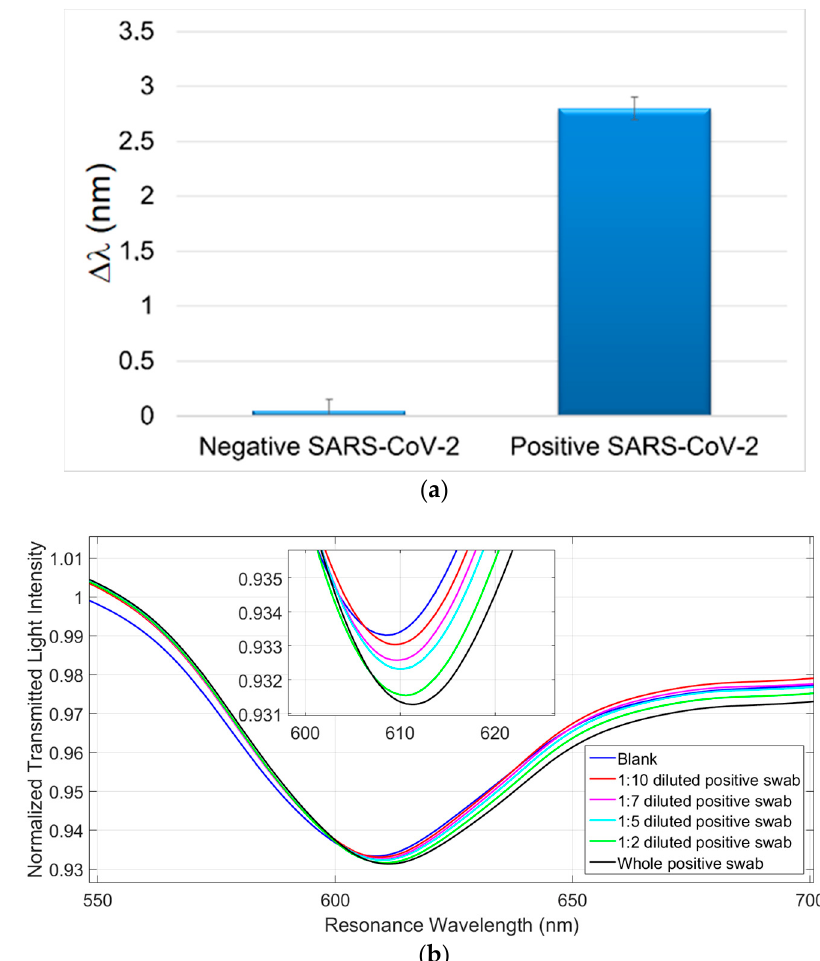
Figure 5. ( a ) Comparison of the response obtained by the MIP-SPR sensor with a negative SARS-CoV-2 swab in UTM (universal transport medium) and a positive SARS-CoV-2 swab in UTM (confirmed by RT-PCR). ( b ) Response curves of SARS-CoV-2 Positive UTM swab (36th RT-PCR cycle), at different dilutions, tested with SARS-CoV-2 MIP-sensor. The samples were diluted with physiological solution.